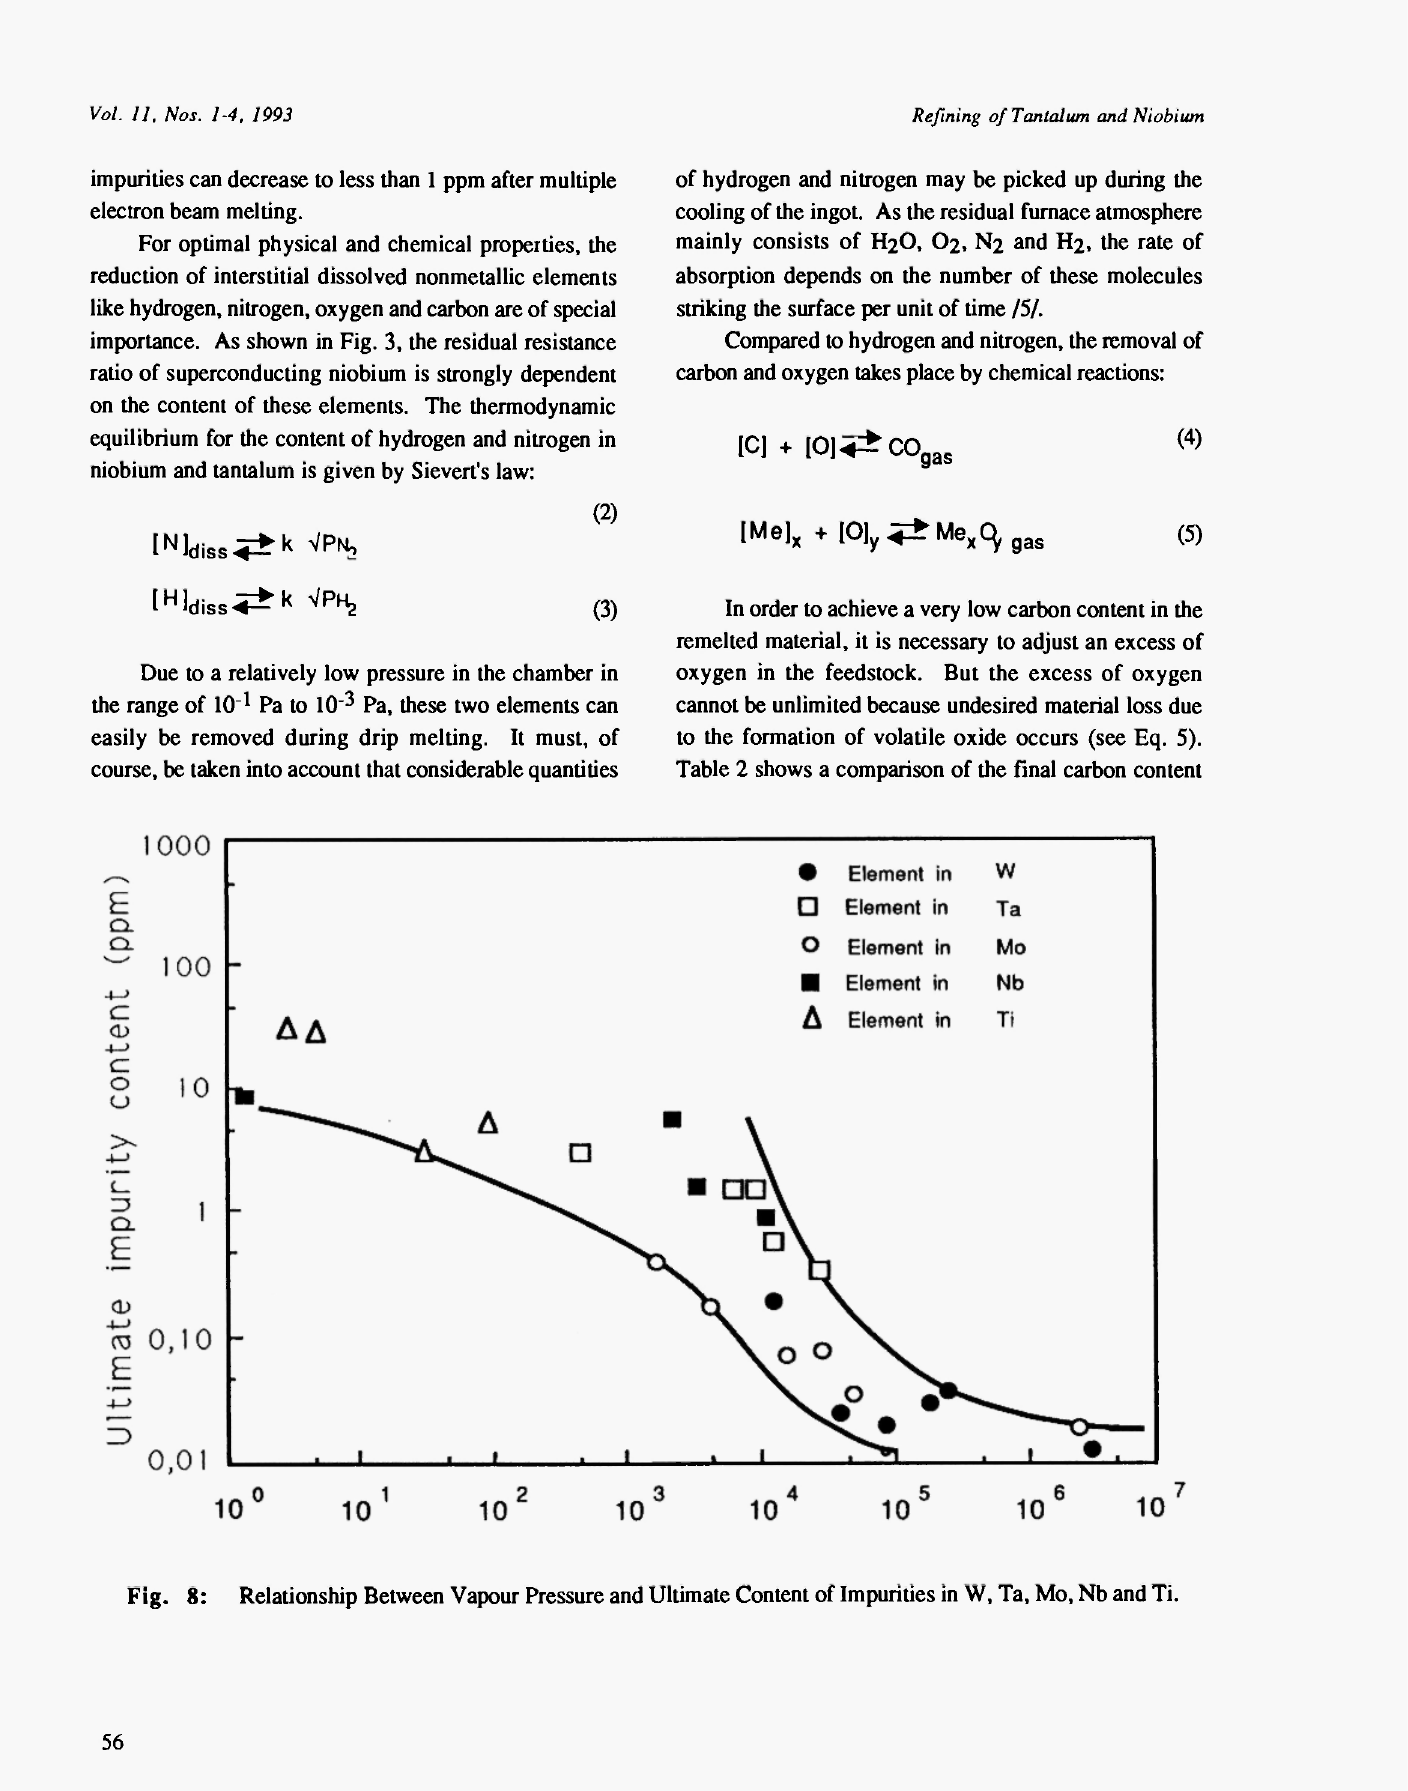
Fig. 8: Relationship Between Vapour Pressure and Ultimate Content of Impurities in W, Ta, Mo, Nb and